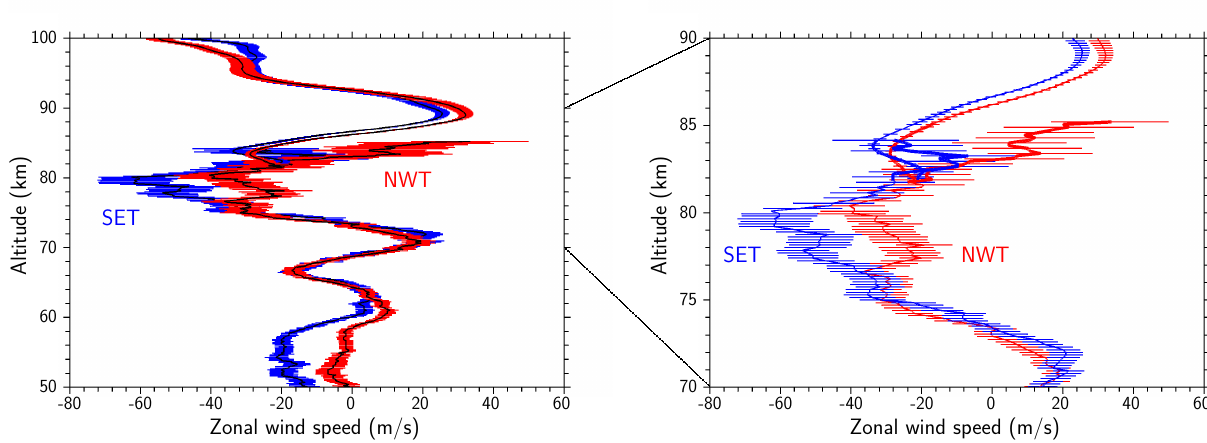
Fig. 7. Zonal wind measured by RMR lidar and Na lidar on 25 January, averaged between 03:25UT and 07:15UT. The NWT (red) pointed to west, the SET (blue) to east. In the altitude range of overlap ( ≈ 82–85km), wind speed profiles from both lidar systems are shown. Left panel: altitude range between 50 and 100km. Right panel: close-up between 70 and 90km altitude; between 80 and 85km error bars are shown for each other data point only; thick lines highlight the height range of overlap.